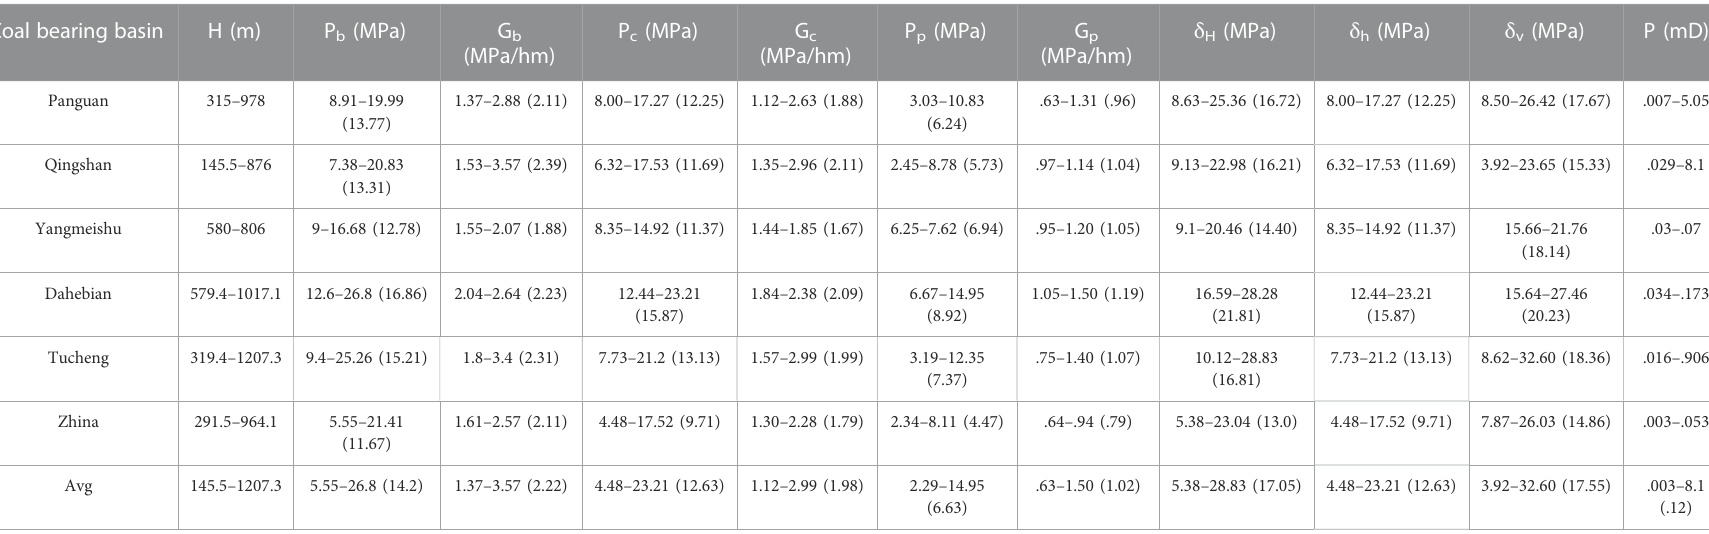
TABLE 1 Statistics of well testing and in situ stress measurement parameters in main coal bearing basins in western Guizhou,